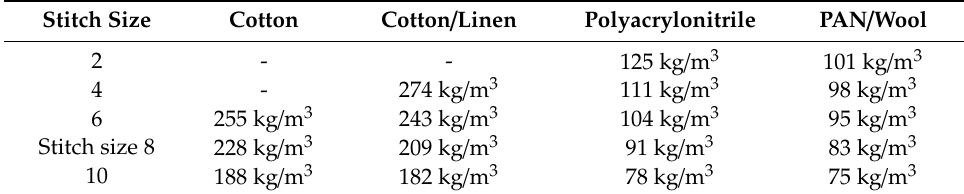
Table 3. Apparent densities of knitted fabrics under examination in this study.